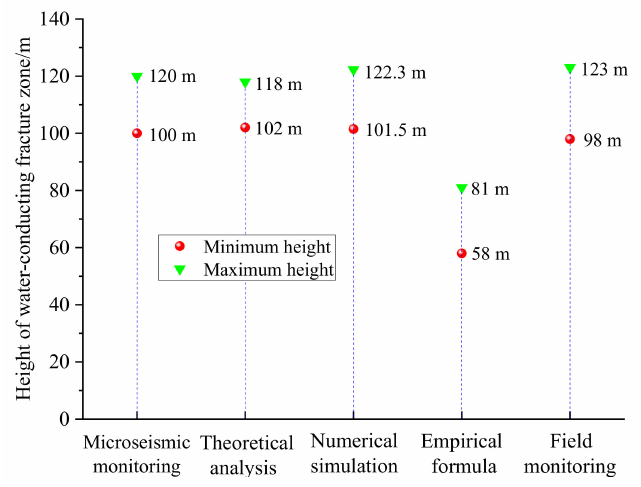
Figure 15. The height comparison of various water-conducting fractured